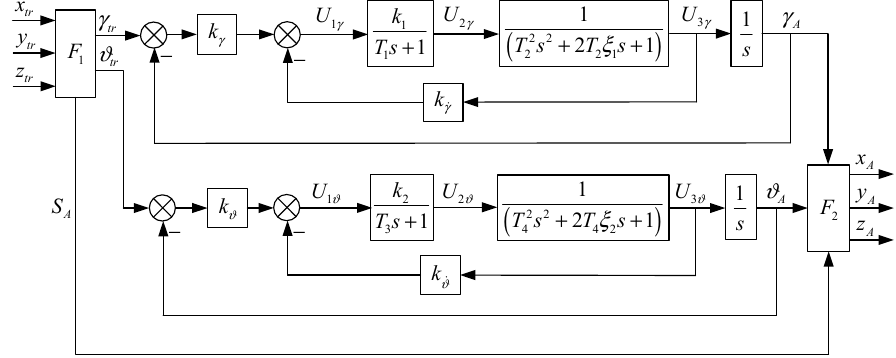
Figure3. Figure 3. Structurally-dynamic scheme of UAV control system for angle in horizontal and vertical planes.